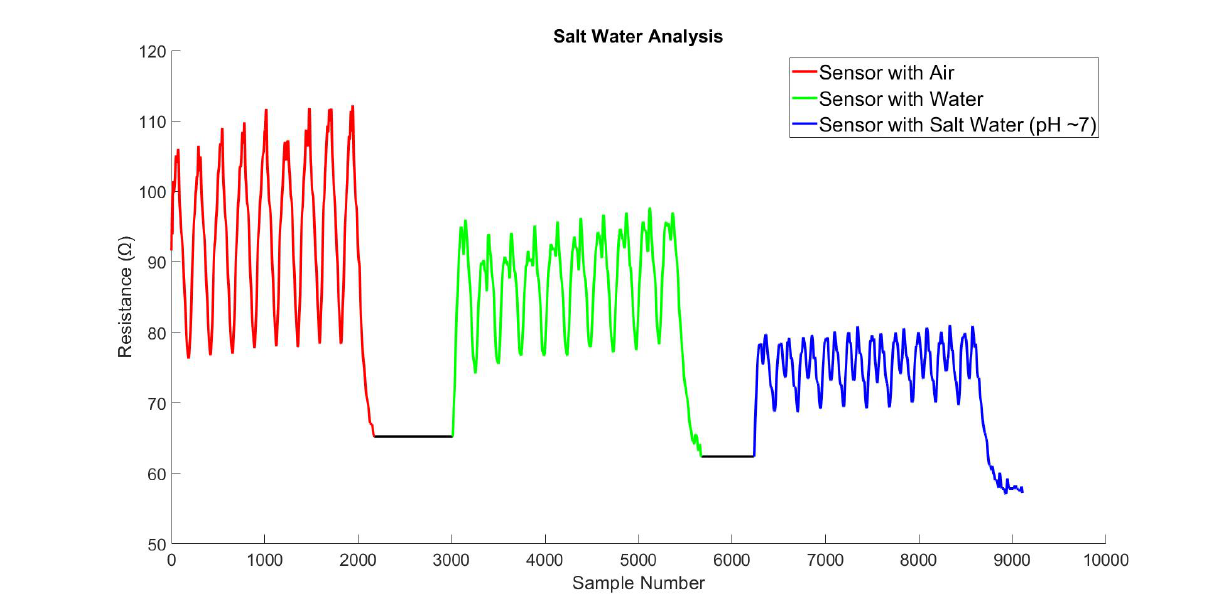
Figure A6. Salt-fog test data of